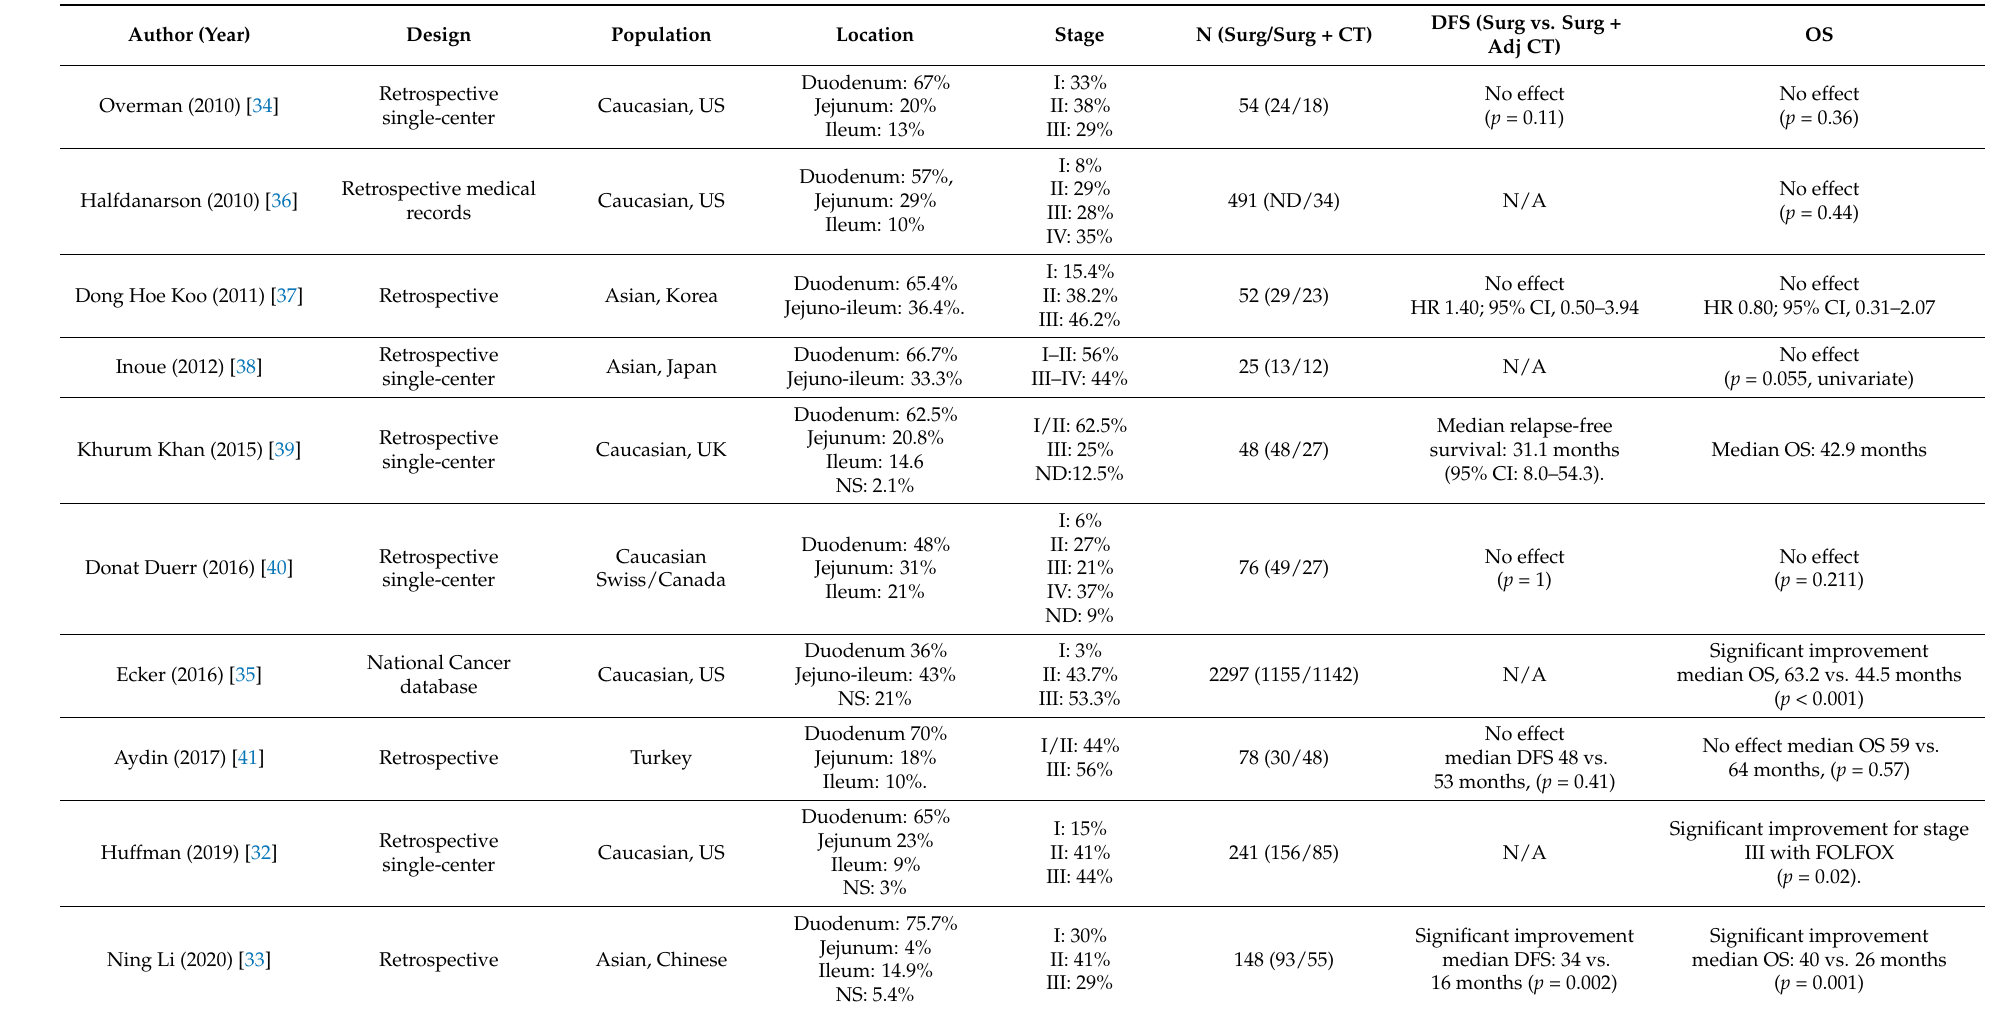
Table 1. Efficacy of adjuvant chemotherapy on disease-free survival and overall survival in small bowel